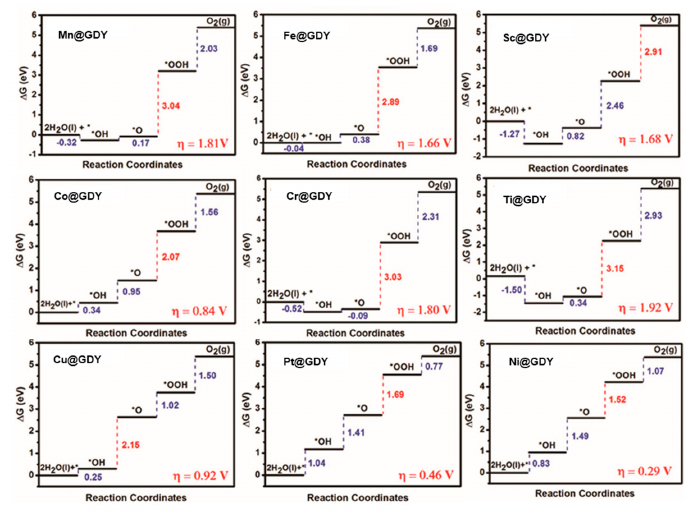
Figure 13. Calculated free energy diagrams of TM@GDY complex for OER under E = 0 V, where the potential-determining step of the elementary reaction is marked in red (reproduced with permission from [123] . Copyright Wiley-VCH, 2019).